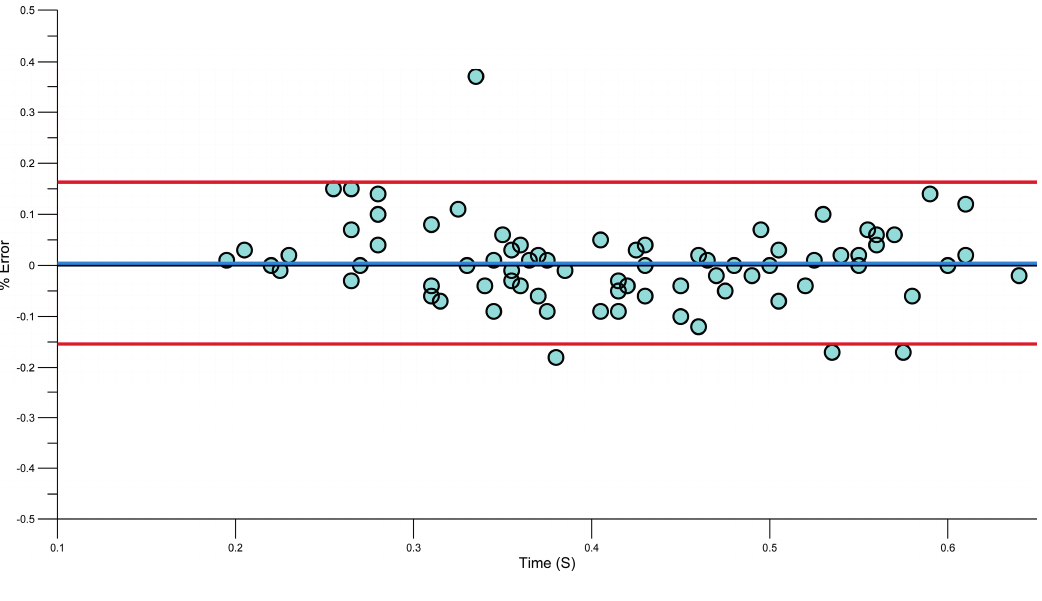
Figure 12. Bland-Altman plot of Entry Duration Error.